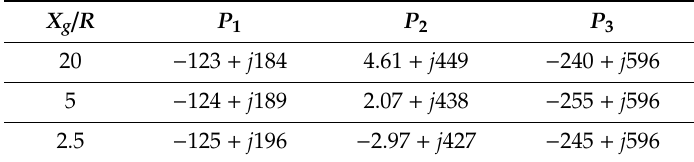
Table 2. Poles for X g / R variations for SCR = 1.25 and X c / X g = 0.